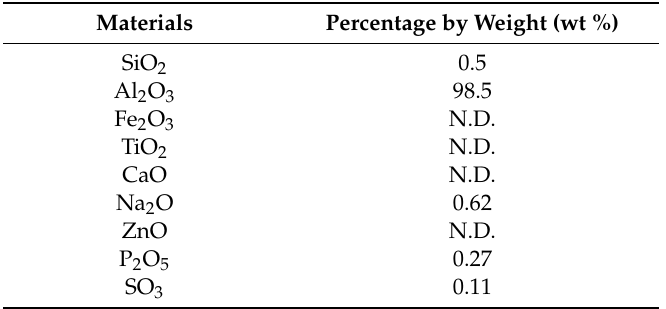
Table 4. Chemical composition of the synthesized Al 2 O 3 . (N.D.: not